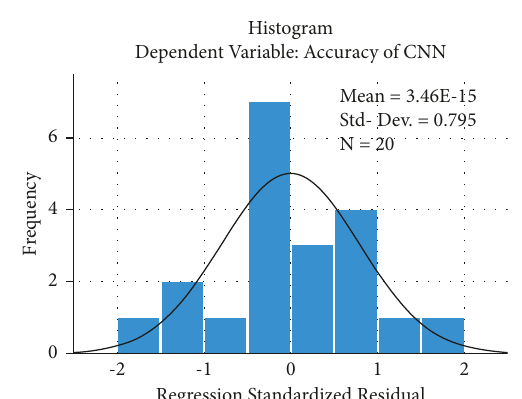
Figure 6: Residualstatistics’plotshowingacenteredbell-shapedcurve.